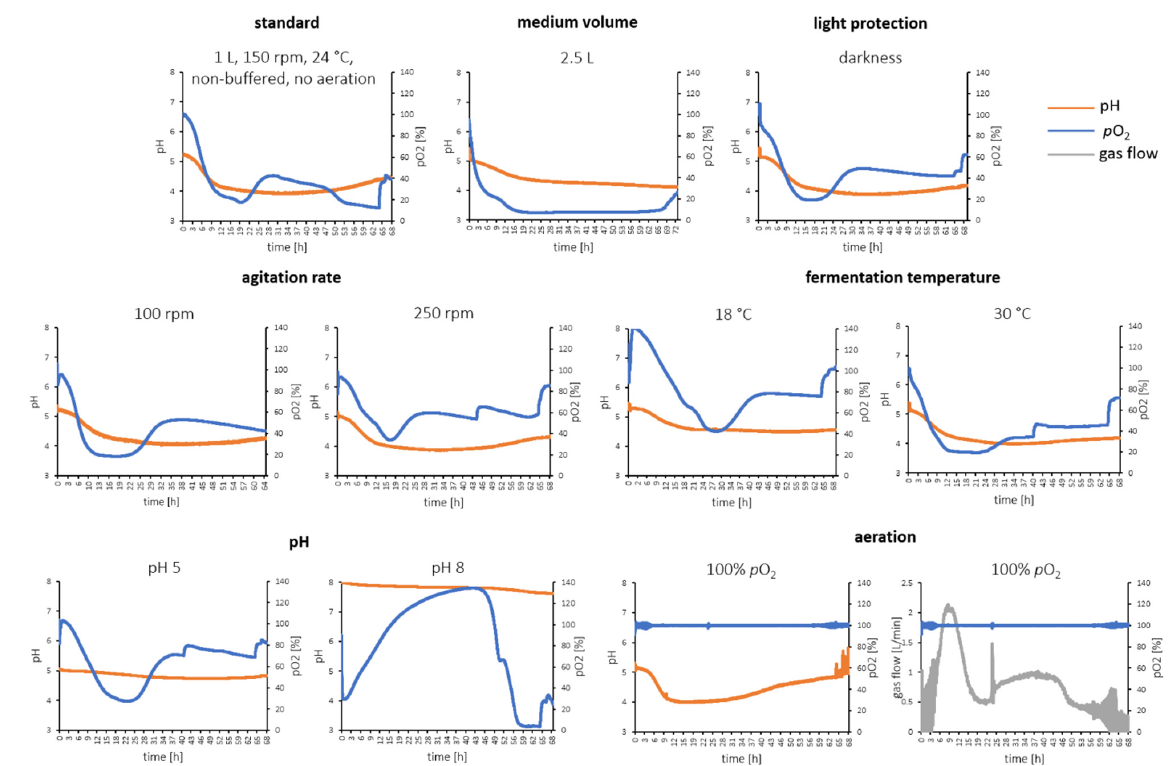
Figure 3. pH and p O 2 monitoring in the fermentation processing with varying parameters (medium volume, light protection, agitation speed, fermentation temperature, pH, and aeration).